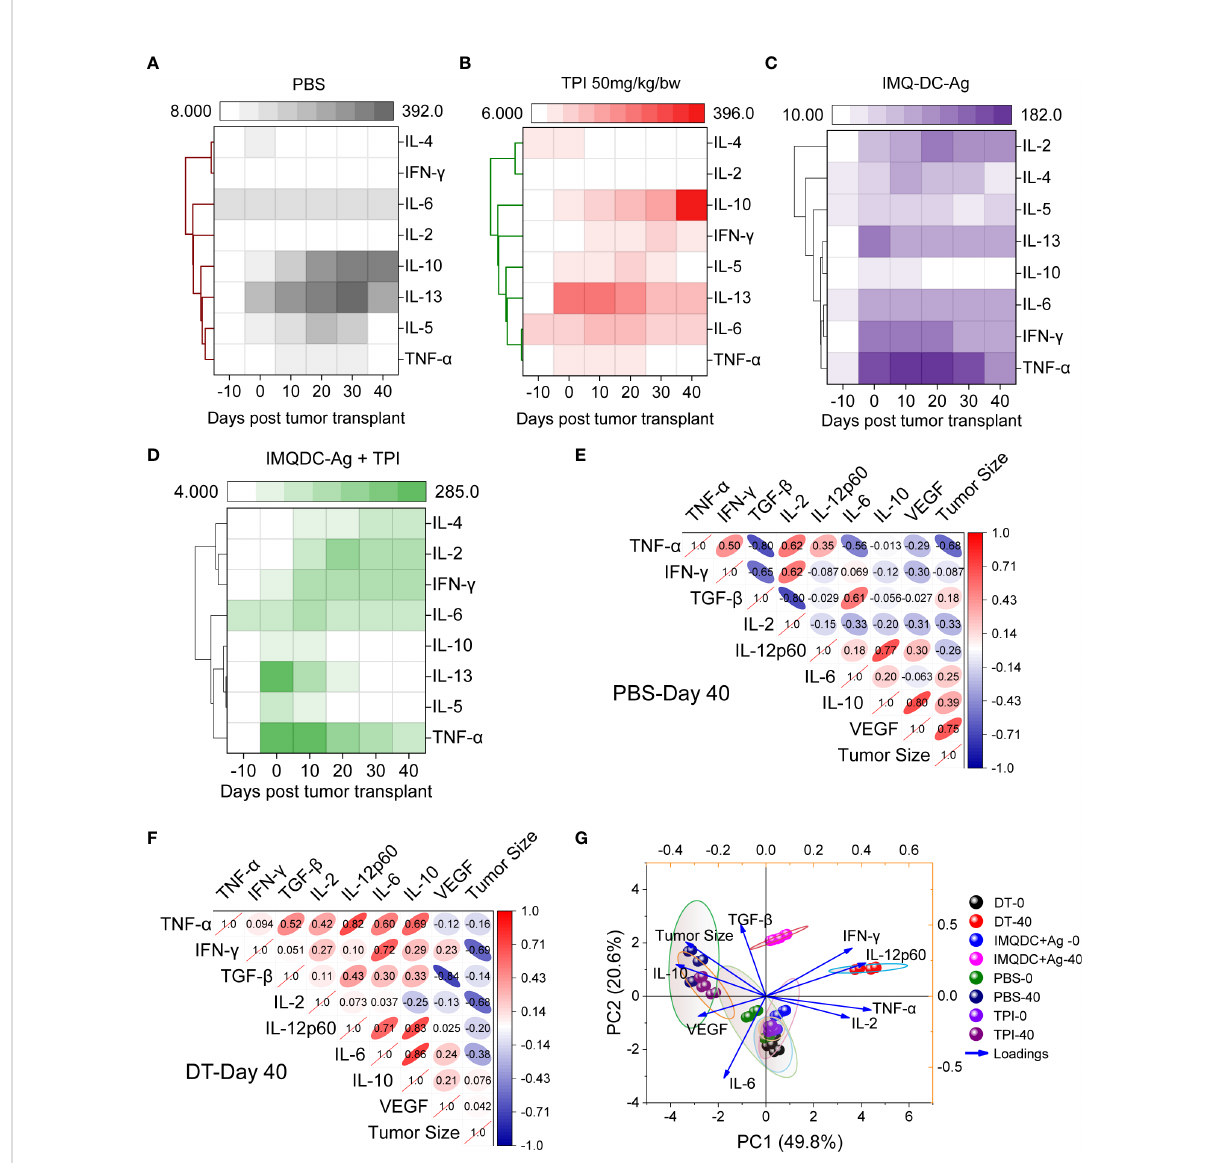
FIGURE 7 Development of Th1-type humoral responses leading to enhanced survival in mice. An 8-plex bead-based multiplex analysis of the Th1/Th2 panel was performed for (A) CT-26 untreated, (B) TPI, (C) IMQDC-Ag and (D) TPI+IMQDC-Ag. A heatmap with a dendrogram on the side shows the clustering of cytokines. The colors in the heatmap represent cytokine expression intensities scaled to the mean of zero and unit variance for each cytokine. Cytokine expression in serum samples detected by ELISA and correlation matrix graph of Pearson ’ s correlation coef fi cients of the indicated cytokine secretion levels in the untreated group (E) vs . dual-treated group (F) at day 40. PCA of various cellular and humoral immune pro fi les regulated during the vaccination periods was performed to predict biomarkers for long-term immune protection (G) . Unless otherwise noted, the data are presented as independent biological